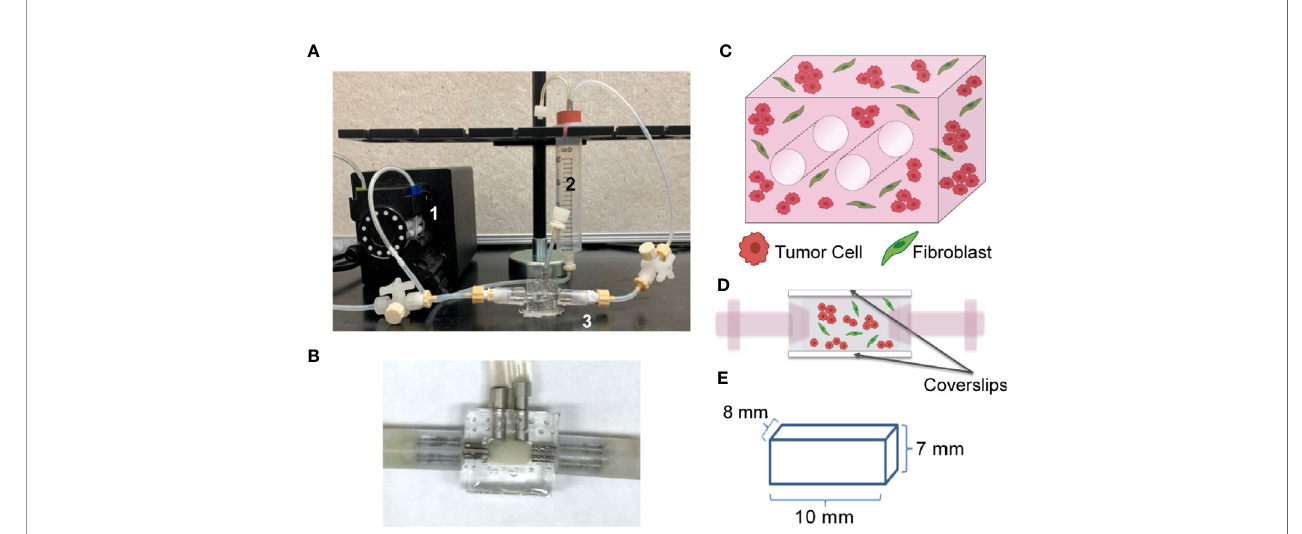
FIGURE 1 | Tissue Engineered 3D Lung Cancer Models Established using a Perfusion Bioreactor Platform. (A) Circulating fl ow loop setup, showing peristaltic pump (1), media reservoir (2), and perfusion bioreactor (3). (B) Perfusion bioreactor containing ECM + cells within the middle chamber. (C) Schematic of the 3D volume, showing 2 through-channels, and mixture of tumor cells and fi broblasts (2:1 ratio). (D) Schematic of side view, showing cells within the central chamber of the bioreactor which has coverslip imaging windows on the top and bottom surfaces. (E) Dimensions of the ECM + cell 3D